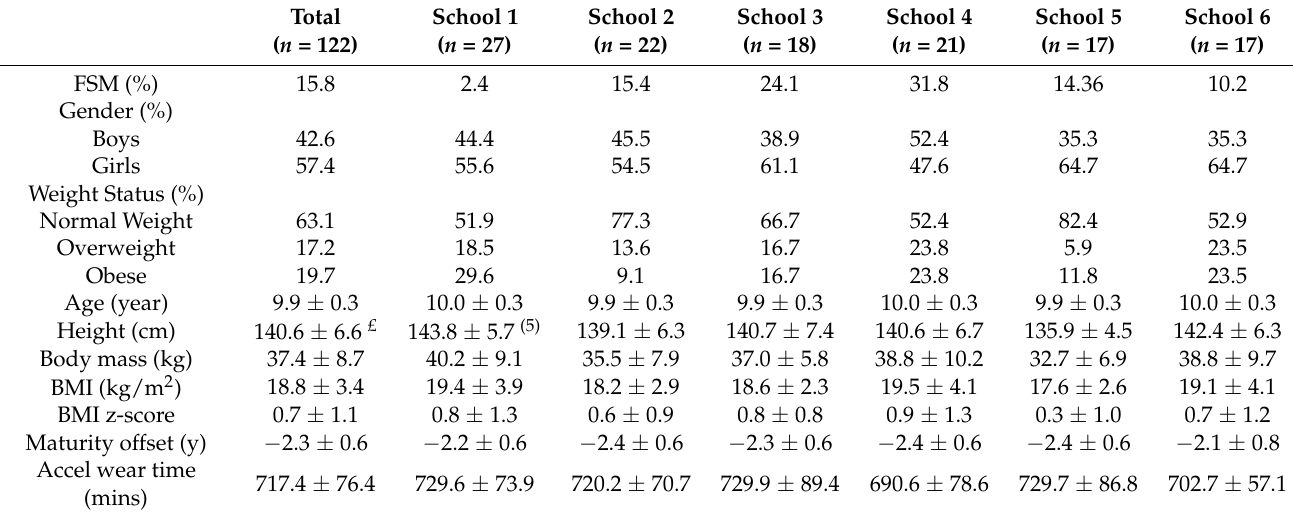
Table 1. Participant descriptive characteristics by school ( Mean ± SD unless